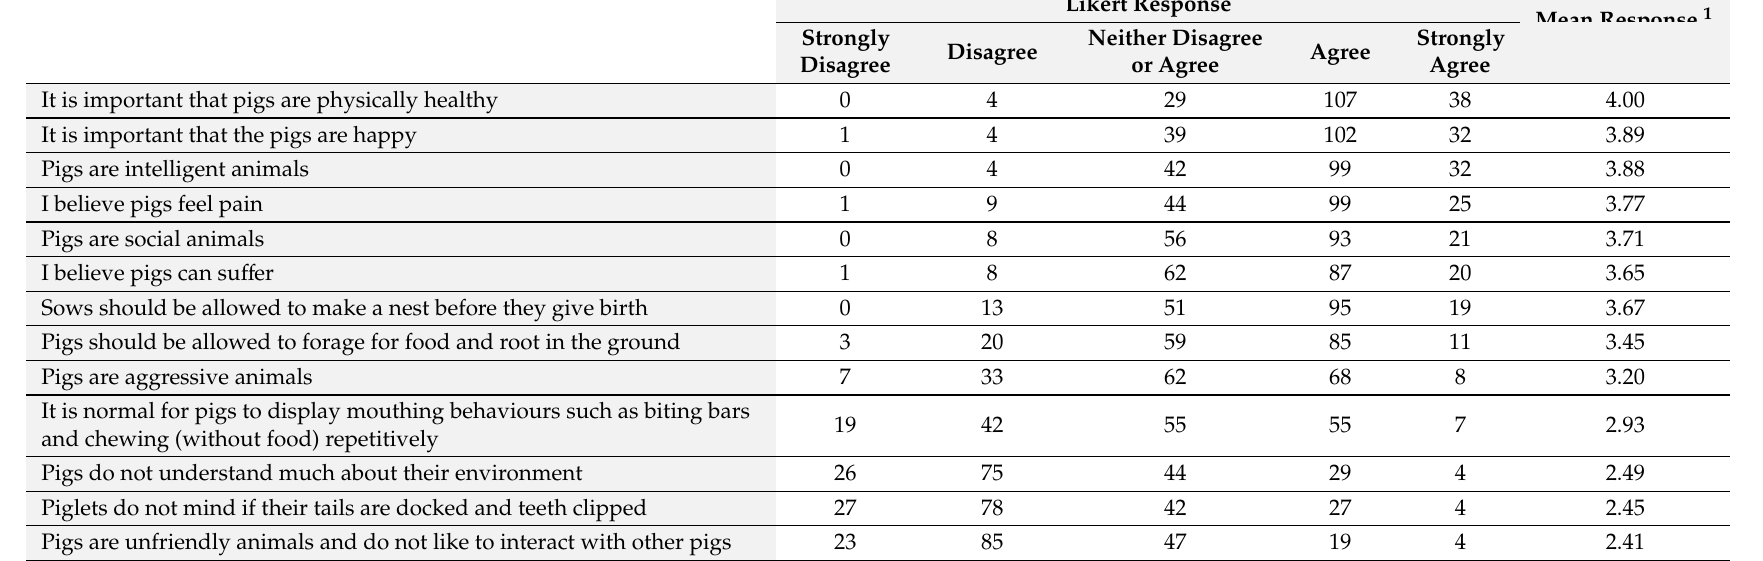
Table 4. Attitudes towards pigs and their behaviour, with di ff erences between mean